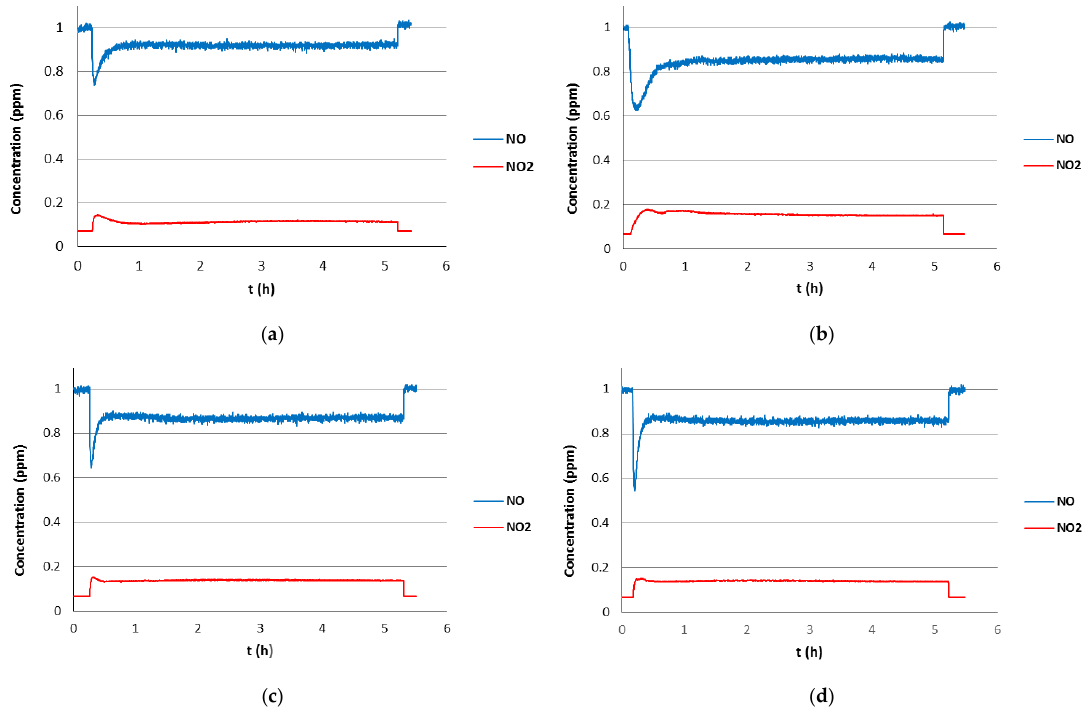
Figure 4. Photocatalytic activity in the degradation of NO(g) of coated-glasses formed by alternating inorganic (TiO 2 ) and inorganic-organic (TiCl 4 /HQ) layers after optimized thermal treatment: ( a ) layers deposited at 2/4 ratio (120 cycles), ( b ) layers deposited at 2/8 ratio (120 cycles). Photocatalytic activity of the last coated-glass in the second ( c ) and third photocatalytic cycle ( d ).